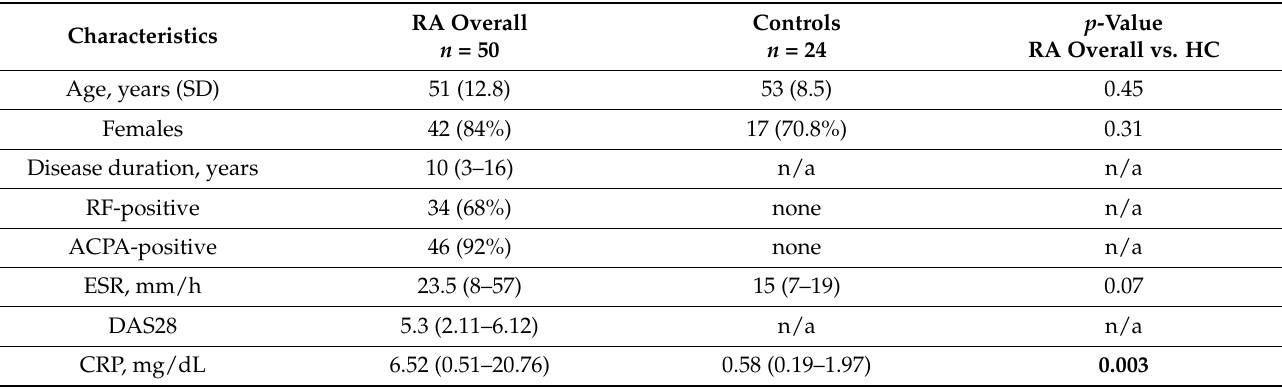
Table 1. Characteristics of